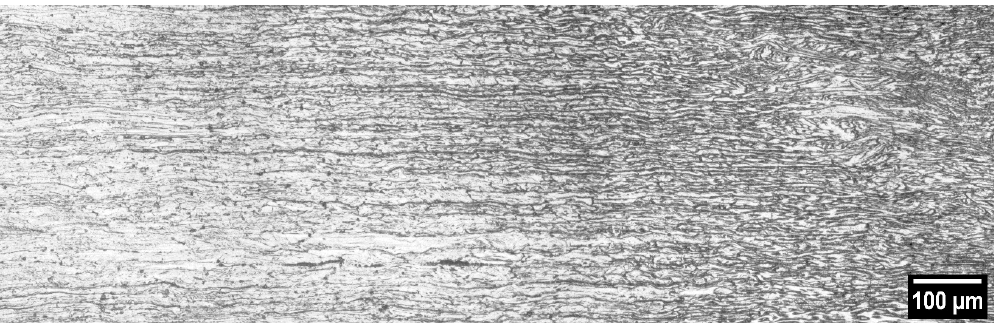
Figure 7. Transversal micrography at the weld bead (right)/HAZ (left) interface after 57% cold rolling.